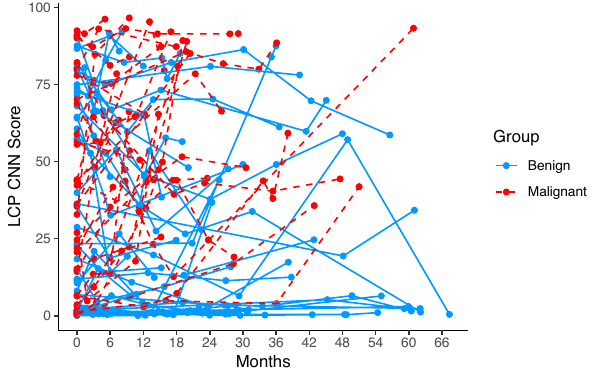
Figure 1. Spaghetti plot with LCP CNN score over time for benign and malignant